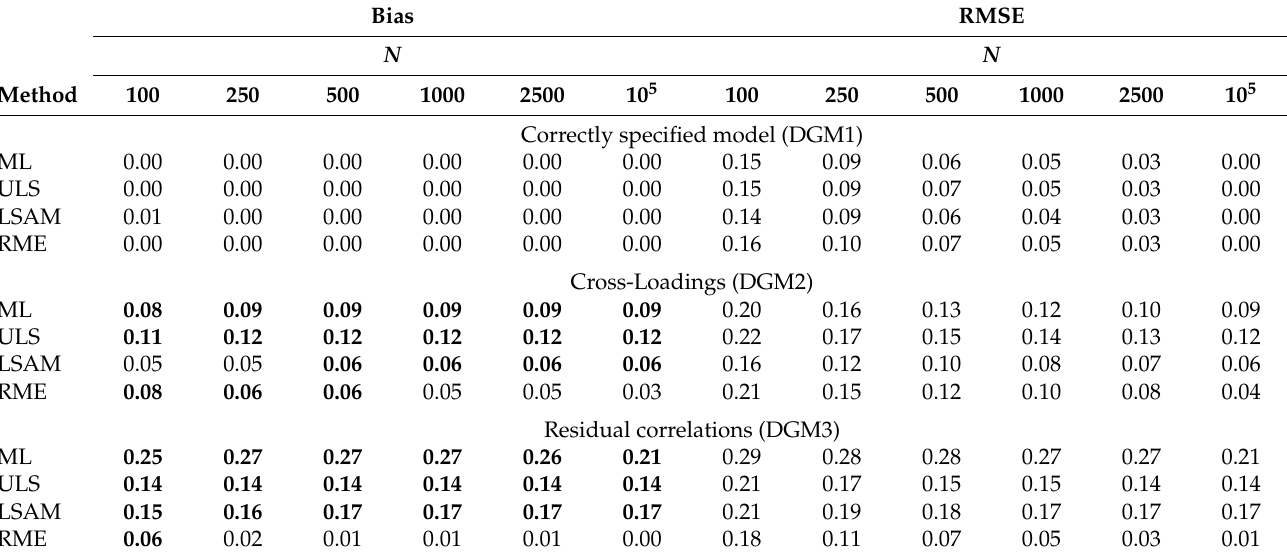
Table 8. Simulation Study 4 (five factors): Average absolute bias and average root mean square error (RMSE) of estimated factor correlation as a function of sample size for the three data-generating models DGM1, DGM2, and